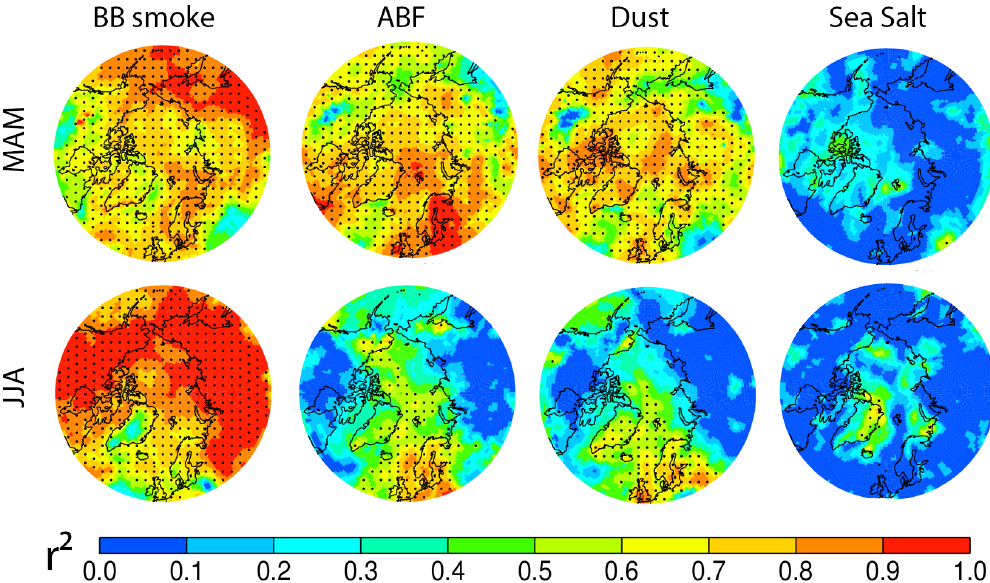
Figure 8. Percentage of interannual MRC variability of MAM (upper row) and JJA (lower row) seasonally binned, total AOD at 550nm explained by BB smoke, ABF/sulfate, dust, and sea salt AODs. Values in dotted area are statistically significant at the 95% level using a two-tailed Student t test.